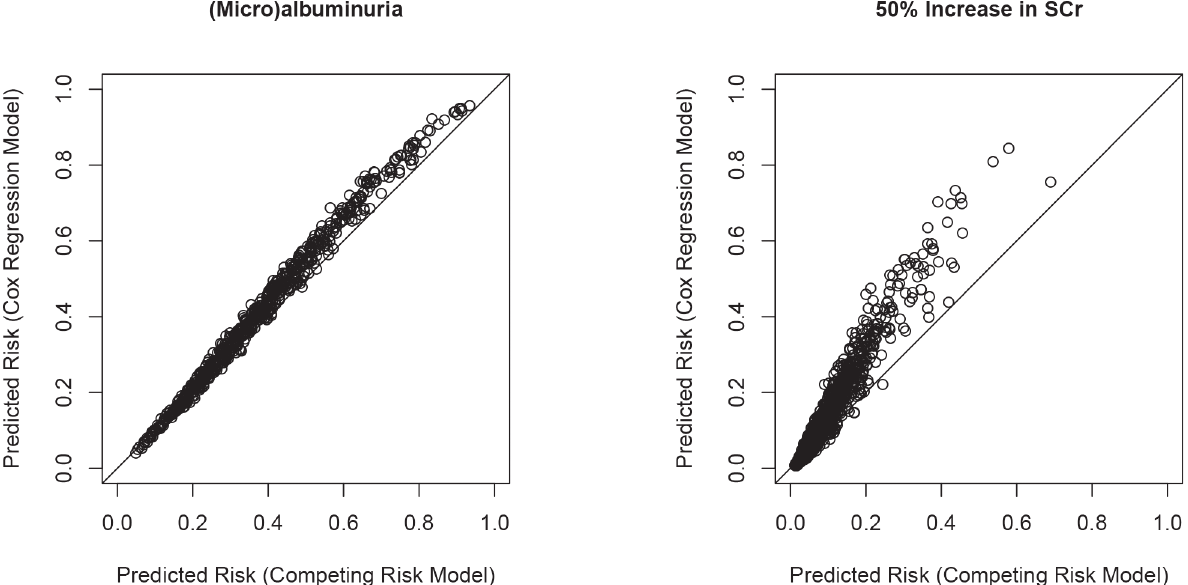
Fig 2. Scatter plots of predicted risks (competing risk models versus Cox regression models) for early stage (i.e. [micro]albuminuria) and late stage renal complications (i.e. 50% increase in